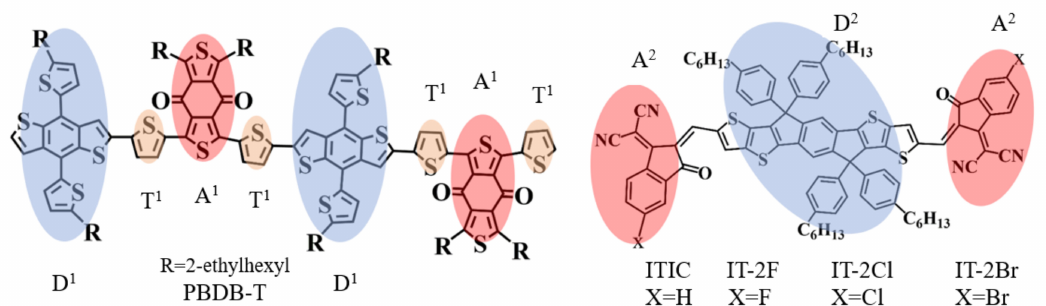
Figure 1. The molecular structures of electron donor PBDB-T, electron acceptors ITIC and IT-2X (X = F, Cl, Br). The polymer donor PBDB-T includes two repeat units. The molecules of electron donor and acceptor materials include electron donor fragments, acceptor fragments and thiophene units that connect the donor and acceptor fragments (labeled D, A, and T 1 in the figure). The fragments D 1 and D 2 are electron donor moieties; the fragments A 1 and A 2 are electron acceptor